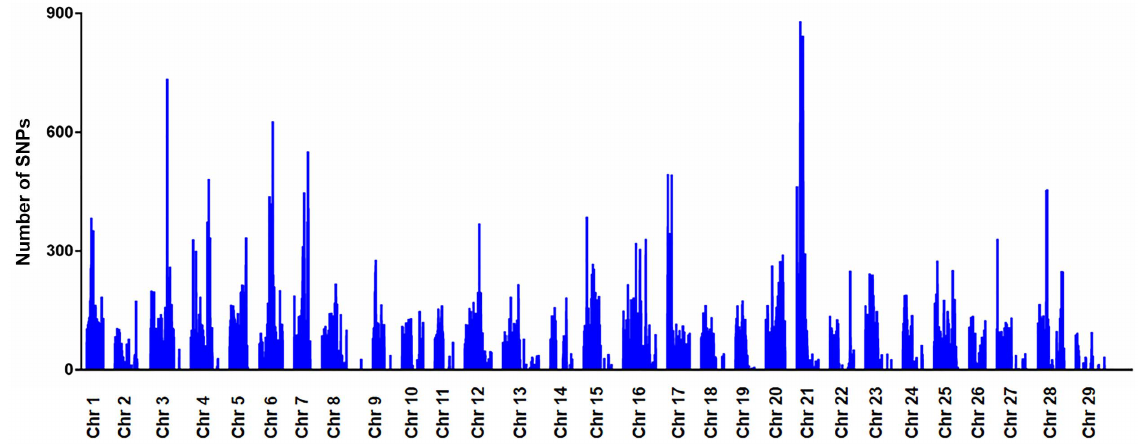
Figure 3. Genome-wide distribution of significant SNPs. Physical positions of all catfish 29 chromosomes are presented on the x-axis, and significant SNP numbers within a window size of 200 Kb is given on the y axis.